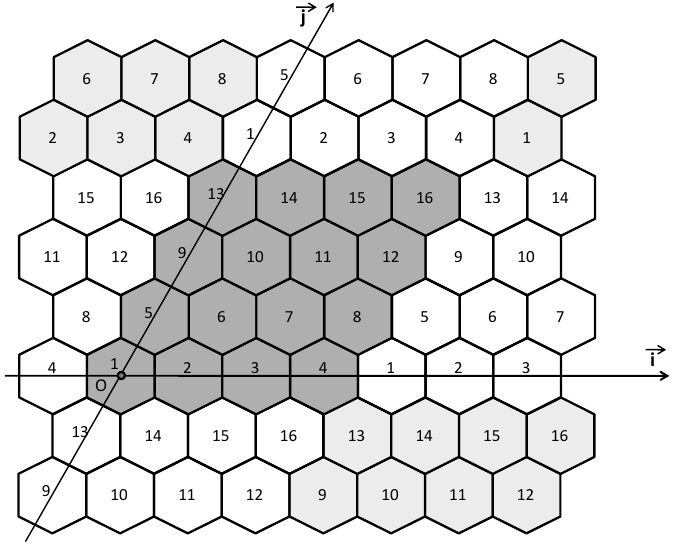
Figure 3. The Coloring Pattern for k =